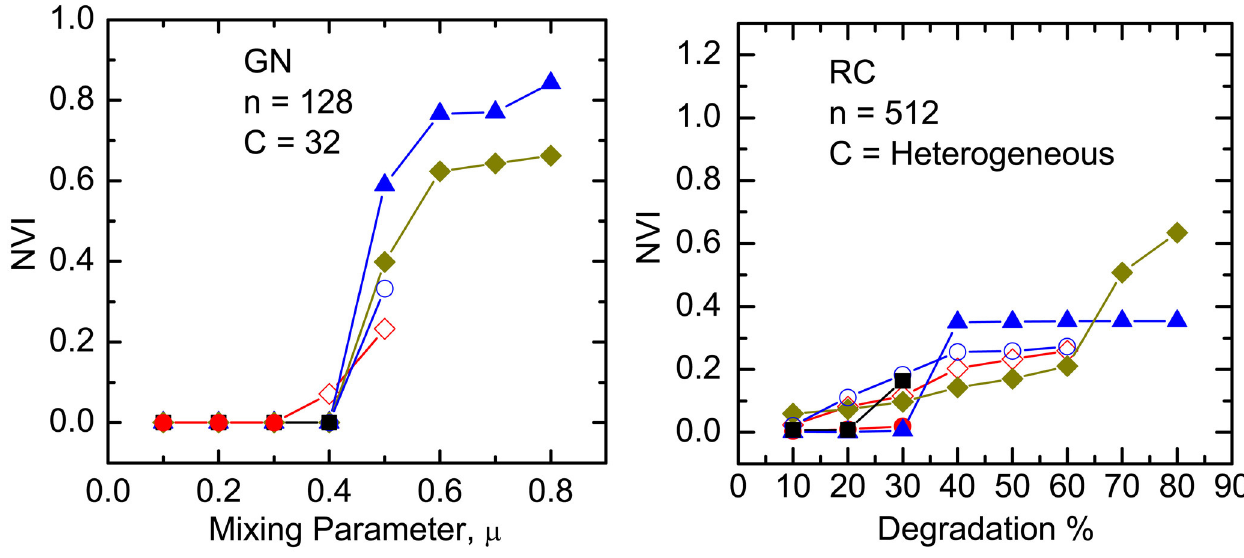
Fig 9. The NVI comparison on undirected and unweighted GN and RC benchmark networks. The size of community for RC ranges from 2 to 157. The legend is the same as in Figs 4 and